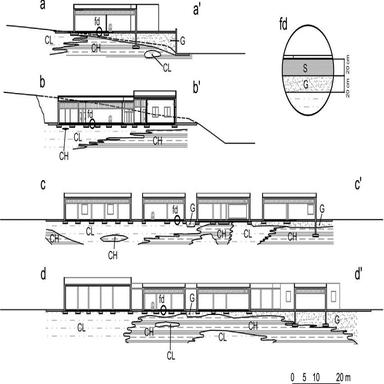
The discontinuous line indicates the ground level before it was excavated. (a) Profile a–a0 of (b) Profile b–b0 of. (c) Profile c–c0 of. (d) Profile d–d0 of. (fd) Foundation detail; ''S", concrete slab, ''G", granular fill.